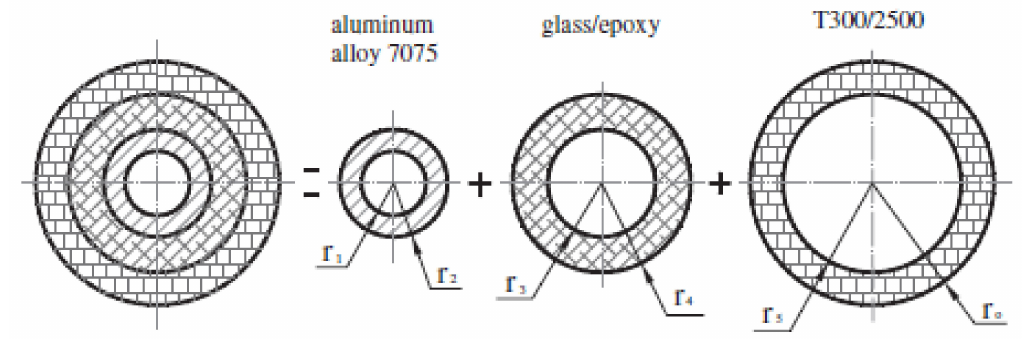
Figure 25. A schematic diagram of hybrid composite flywheel structure, reproduced with permission from Elsevier [144].